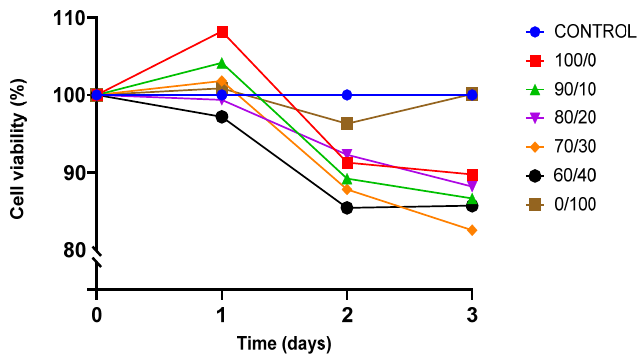
Figure 7. Presto Blue viability assay towards BEAS-2B cells.